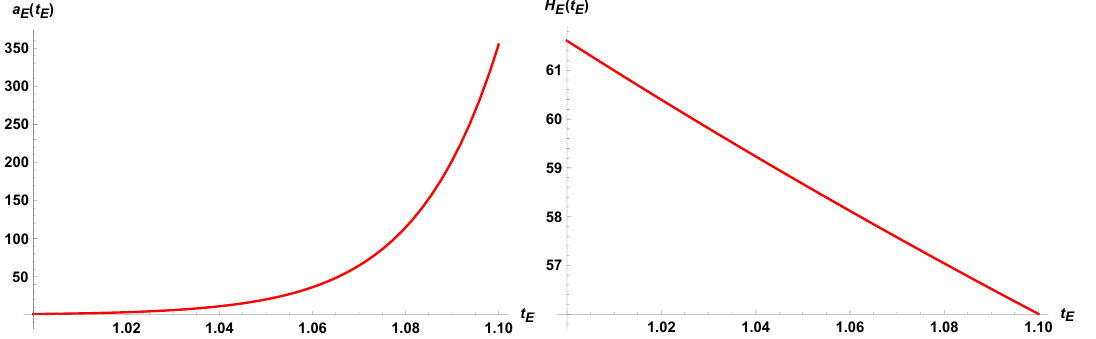
Figure 8 . The scale factor a E ( t E ) (left panel) and the Hubble parameter H E ( t E ) (right panel) in Einstein frame in the model with χ = 0 . 4 , n S = 0 . 967 (and µ = 1 . 0099 ). factor (2.11) and Hubble parameter H = χ/t in Jordan frame for the contraction stage. For example, a ( t ) /d and H for χ = 0 . 4 , n = 0 . 967 , (and i.e. for µ = 1 . 0099 ) are S